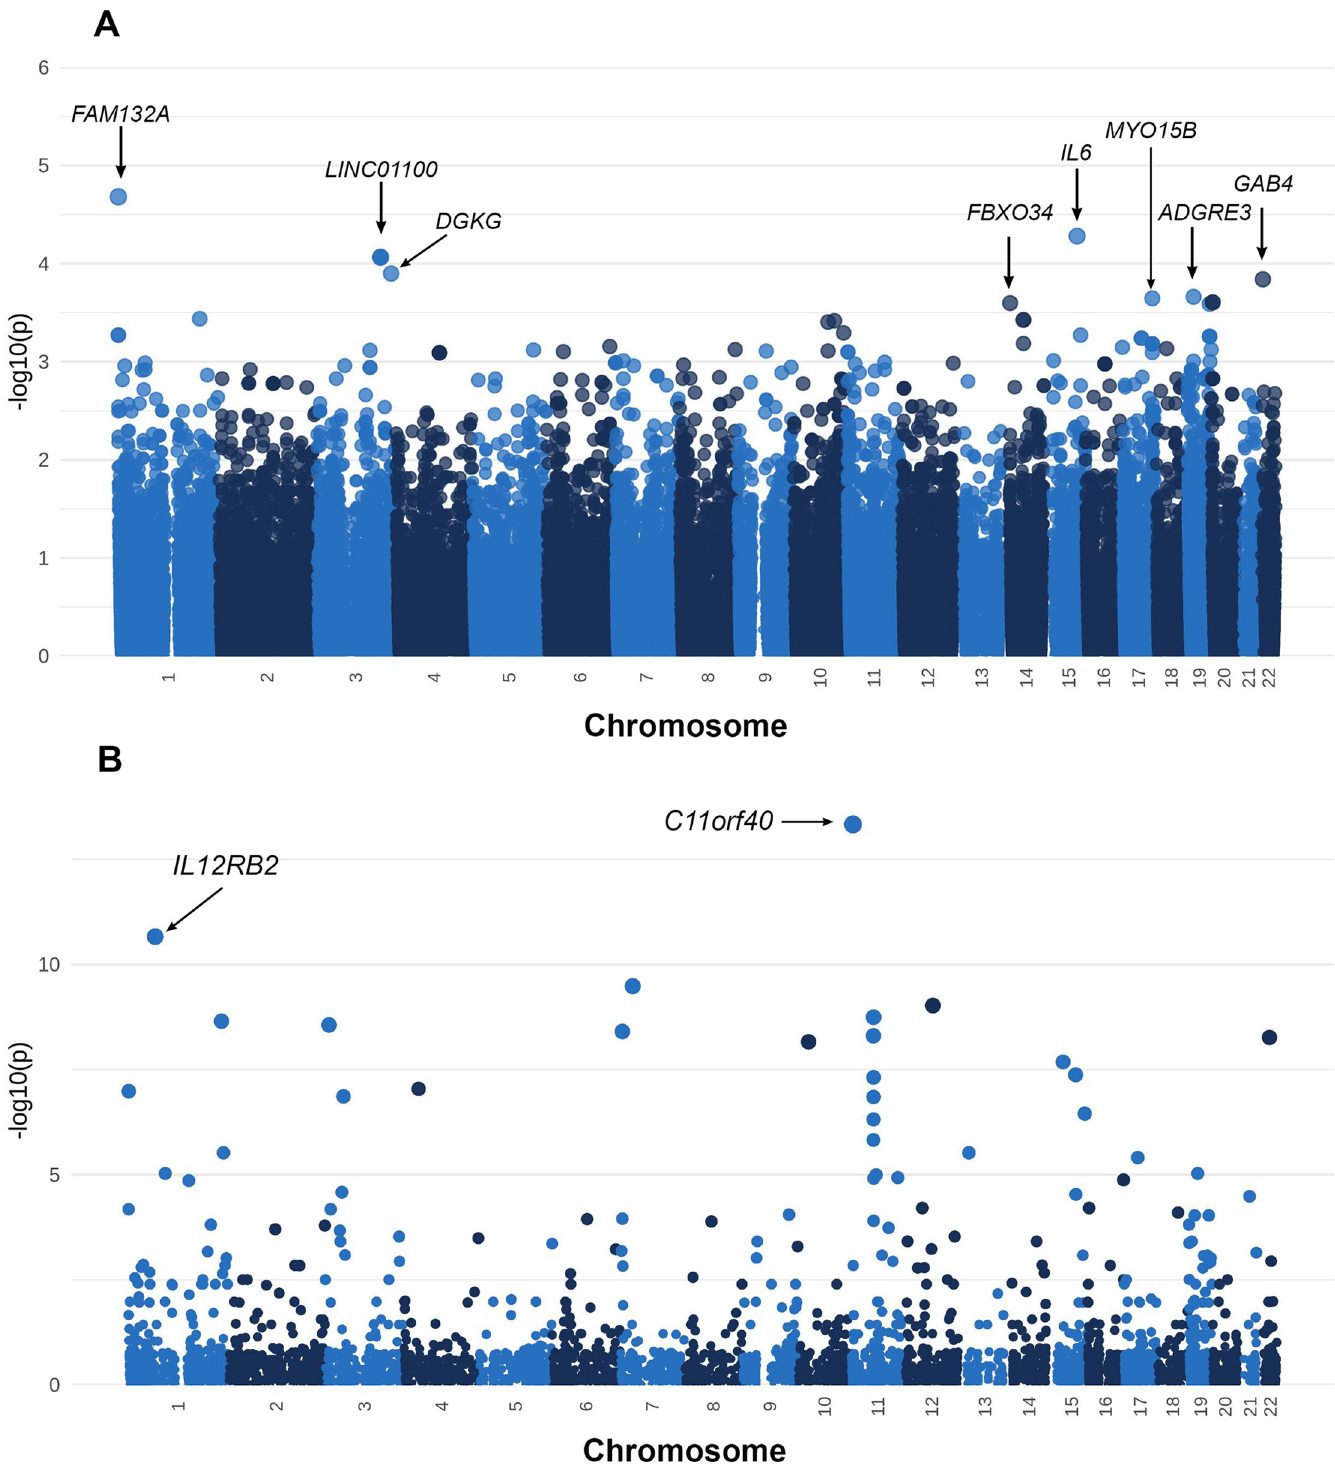
Fig 3. Association analyses of common and rare variants. (A) Manhattan plot of the Firth’s logistic modelling for common variants of the CZS dataset (n = 35). We modeled the parameters considering the binary response (CZS / Control) and the genetic variants while adjusting for the gestational exposure to ZIKV in the mother. Each point corresponds to a genetic variant. (B) Manhattan plot of the results of the C-alpha test of the CZS dataset (n = 35), we determine the differential distribution and accumulation of rare variants grouped in genes between cases and controls. Each point represents a gene.